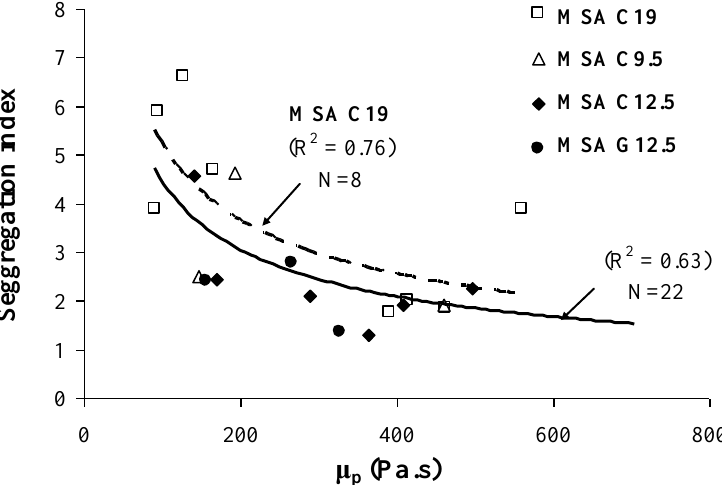
Figure 9. Variations of the segregation index and plastic viscosity determined at 10